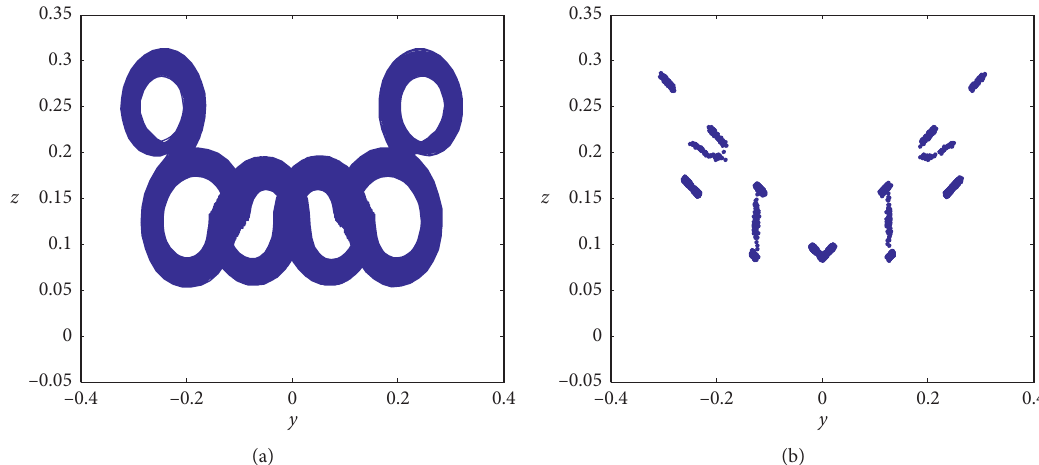
Figure 1: Numerical simulation results under m � 1 and n � 1. (a) y - z phase diagram shows six-scroll chaotic attractors; (b) Poincar´e map on x � y plane shows its chaotic